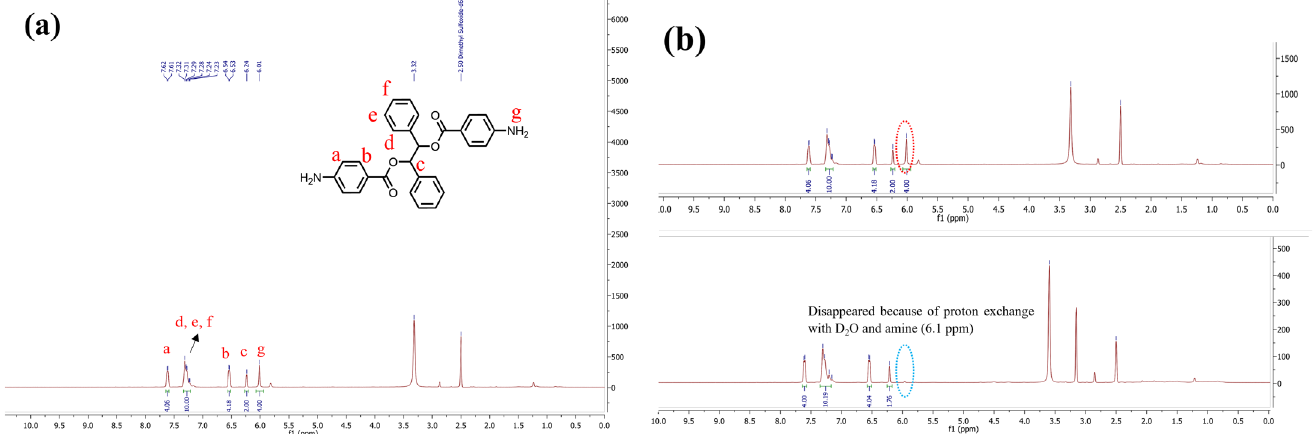
Figure 2. 1 H-NMR spectra of ( a ) 1,2-DPEDBA and ( b ) 1,2-DPEDBA with addition of D 2 O. The 13 C-NMR spectra of 1,2-DPEDBN and DPEDBA are shown in Figure 3. All peaks in the figures are assigned to each carbon atom in the chemical structure. In Figure 3a, the peak at 162 ppm (‘e’) was assigned to the ester carbonyl (C=O) carbon atom, the peak at 150 ppm (‘a’) was assigned to the nitro group carbon (C-N) atom, and the peaks at approximately 120~135 ppm (‘b, c, d, g, h, i, j’) were assigned to the phenyl carbon atom. The peak at 77 ppm (‘f’) was assigned to ethyl carbon. In Figure 3b, the peak at approximately 160 ppm (‘e’) was assigned to the ester carbon atom, and the peak at approximately 150 ppm (‘a’) was assigned to amine carbon. The peak at approximately 76 ppm (‘f’) was assigned to ethyl carbon. The other peaks were assigned to phenyl carbon (‘b, c, d, g, h, i, j’) [41].